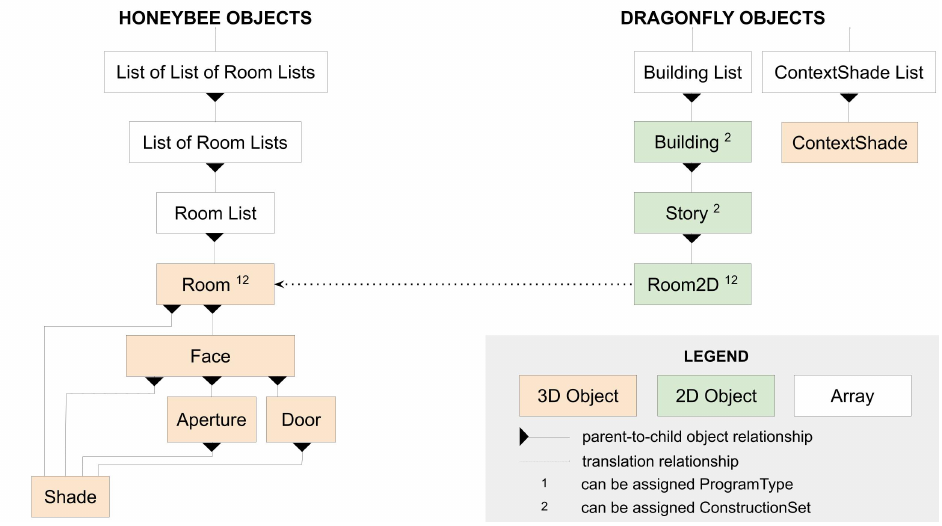
Figure 4. URBANopt SDK Gem structure.